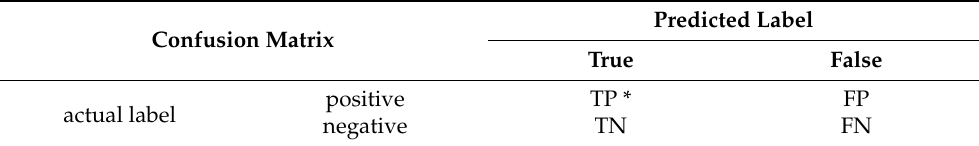
Table 3. Confusion matrix of binary classification of artificial intelligence. Confusion